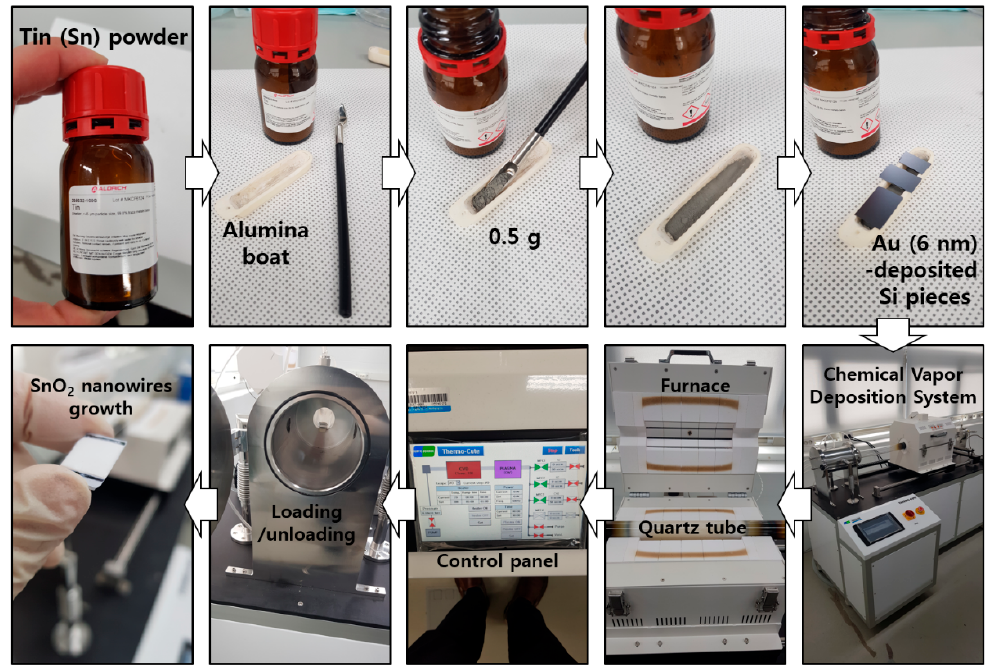
Figure A1. Synthesis procedure of SnO 2 NWs, using CVD system. SnO 2 NWs were grown on Au-deposited Si samples. Samples were loaded inside the Quartz tube with 0.5 g of tin powder in an alumina boat. After raising the temperature of the furnace up to 750 ◦ C, SnO 2 NWs were vertically grown for 30 min.